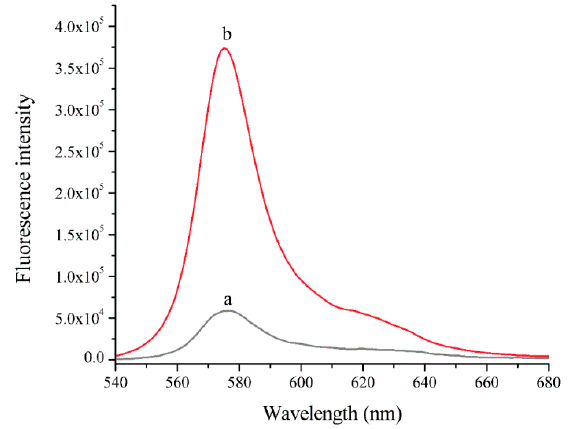
Figure 2. Fluorescence emission spectra of DNAzyme-R-PE incubated with 0 nM (curve a) and 150 nM (curve b) Pb 2+ in HEPES buffer.